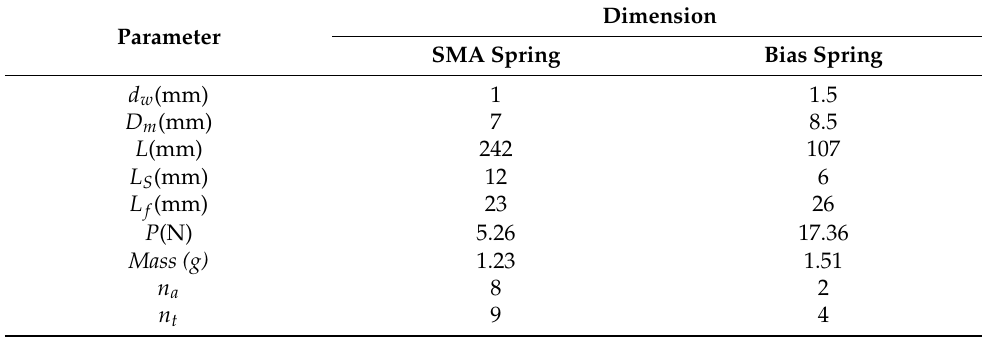
Table 4. Dimensions of the SMA spring and bias